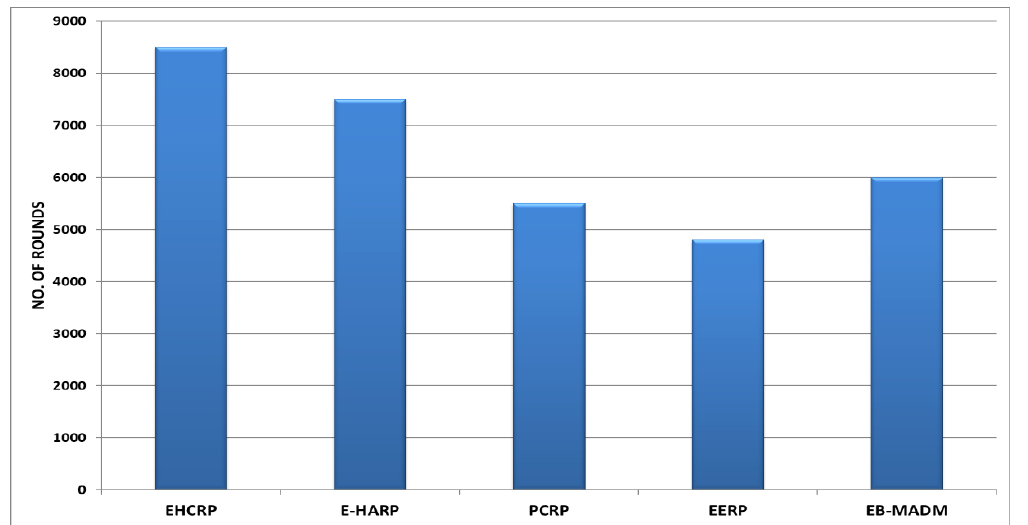
Table 5. Live nodes vs. rounds.